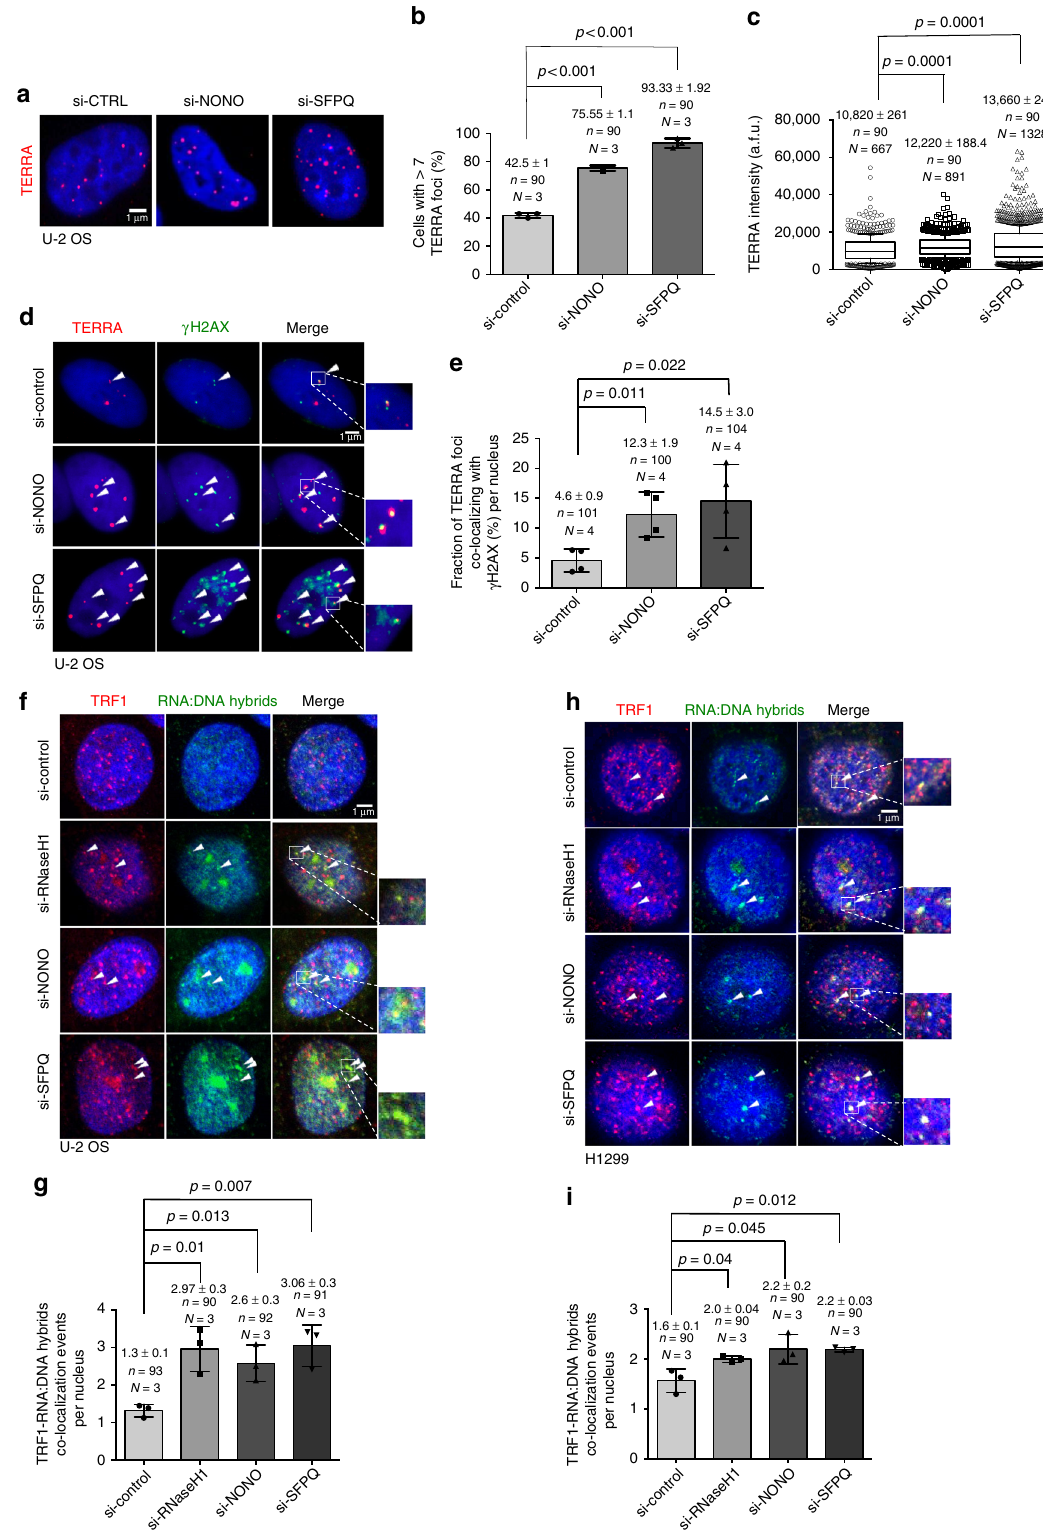
RNA:DNA hybrids RNA:DNA